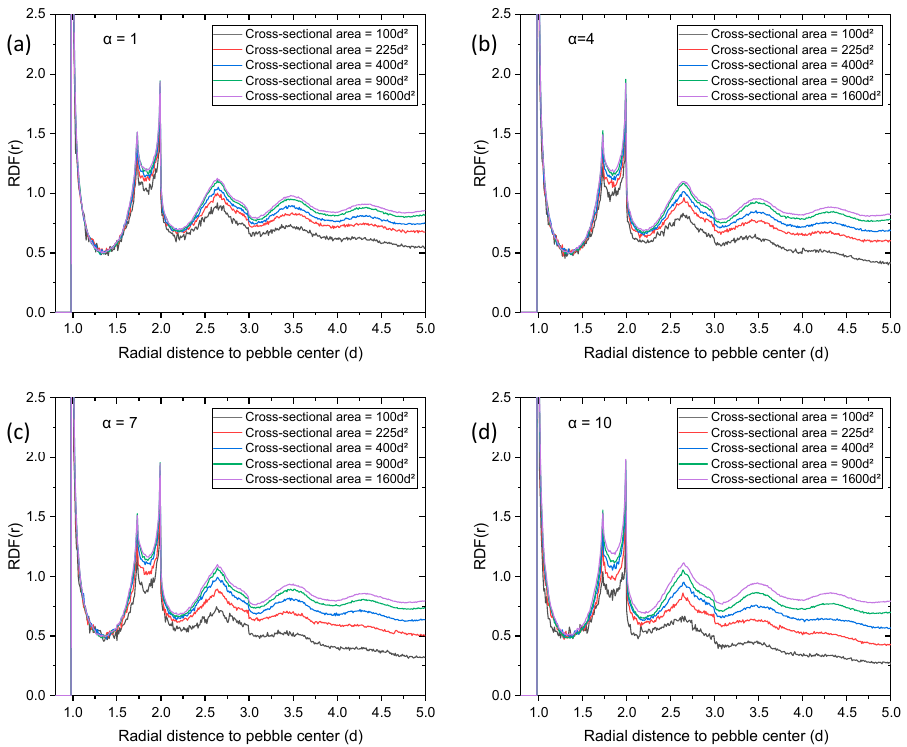
Figure 18. RDFs of the pebble beds with different cross-sectional bed areas of 100 d 2 –1600 d 2 and aspect ratios of ( a ) α = 1, ( b ) α = 4, ( c ) α = 7, ( d ) α = 10.